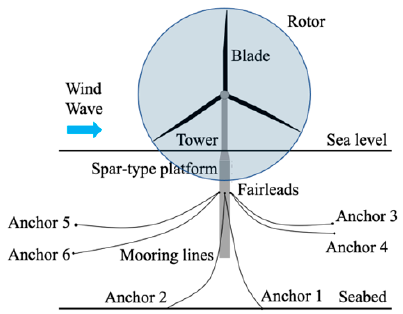
Figure 5. Developed mooring system that uses six mooring lines to connect floating wind turbine.